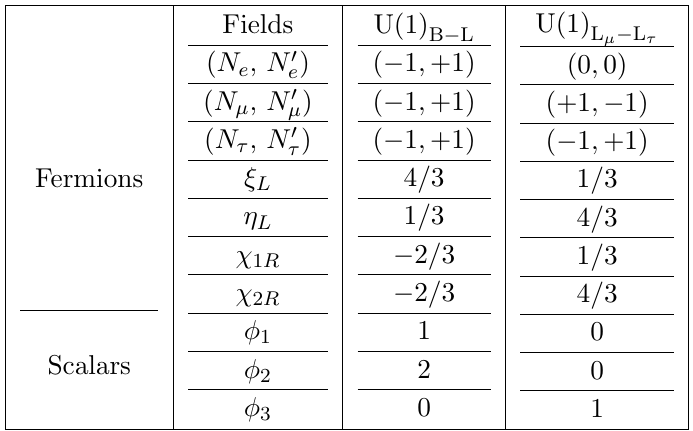
Table 1 . BSM particles and their corresponding charges under the U(1) group where all of them are singlet under SM gauge group (SU(3) c